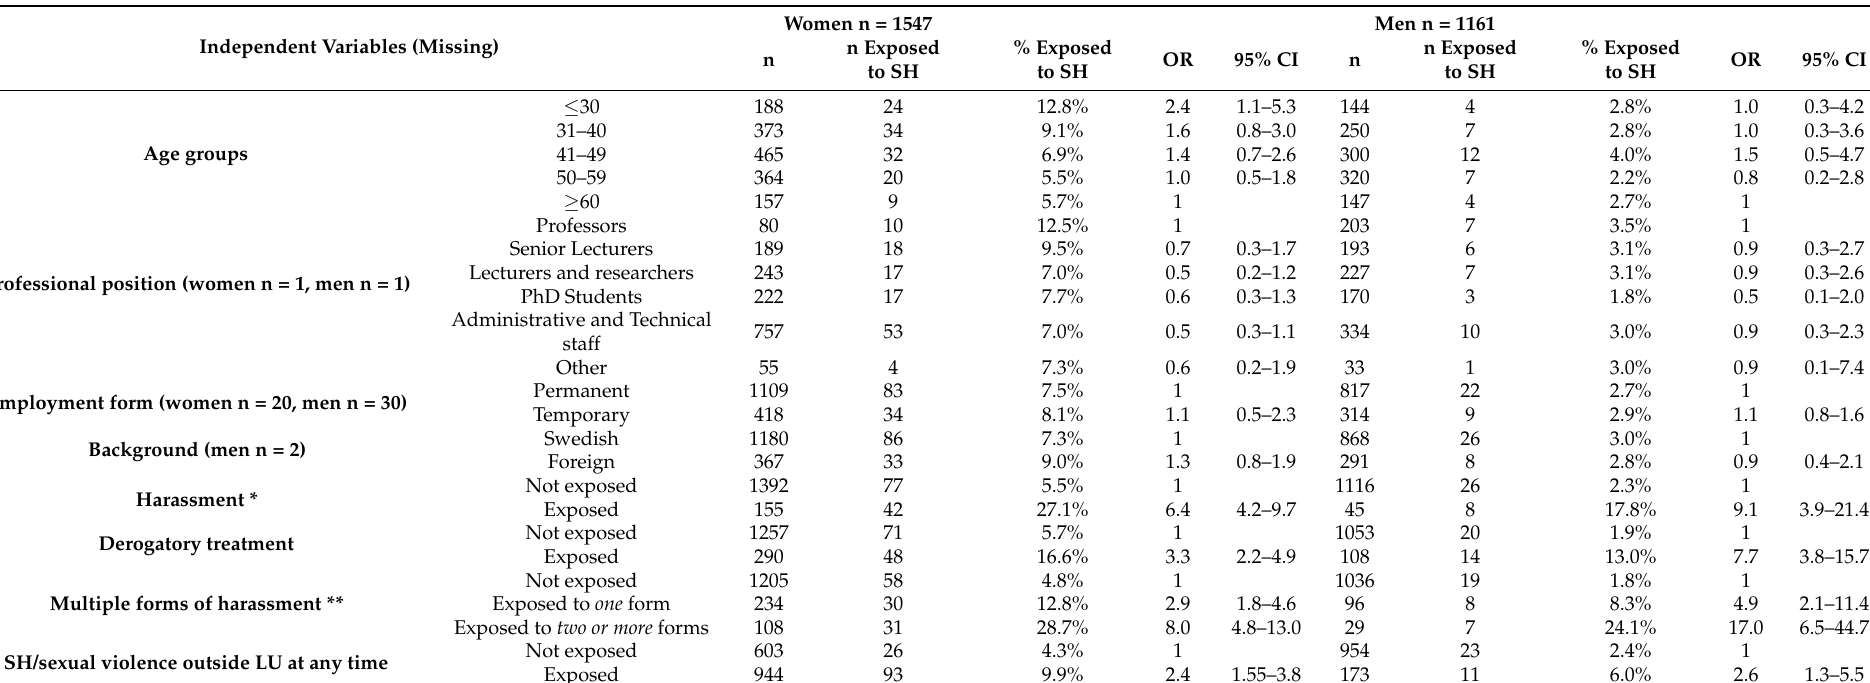
Table 5. Association between background variables, harassment *, derogatory treatment, experience of SH/sexual violence outside of Lund University and sexual harassment at Lund University, by gender. Bivariate logistic regression analysis. Independent Variables